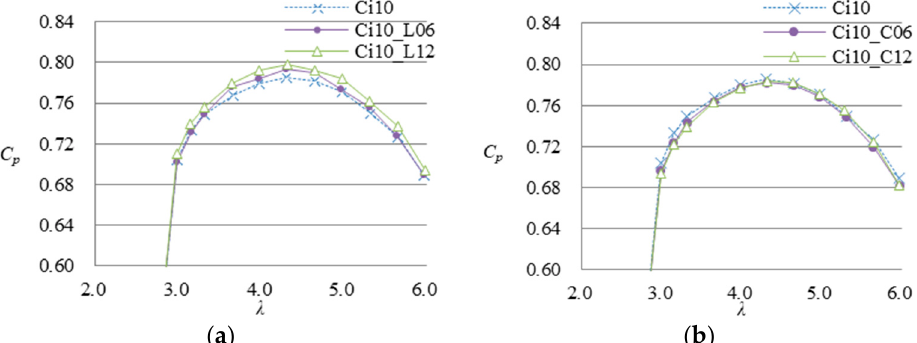
Figure 15. Power curves of WLT Ci10: ( a ) Results of the WLT with the polygonal brim with straight sides; ( b ) Results of the WLT with the polygonal brim with curved sides.